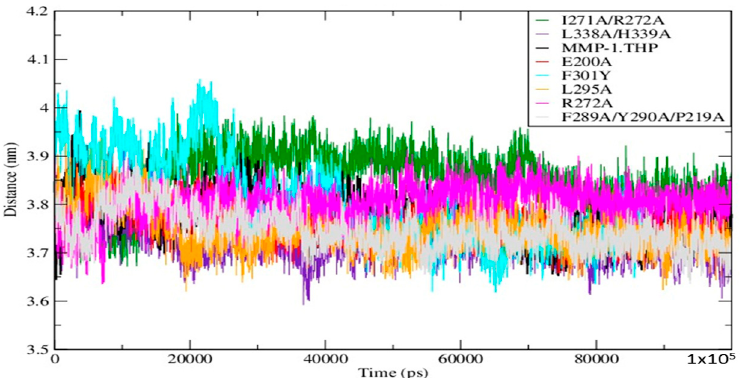
Figure 6. The distance between the center of mass of the CAT and HPX domains comparing the mutant forms and WT MMP-1•THP.